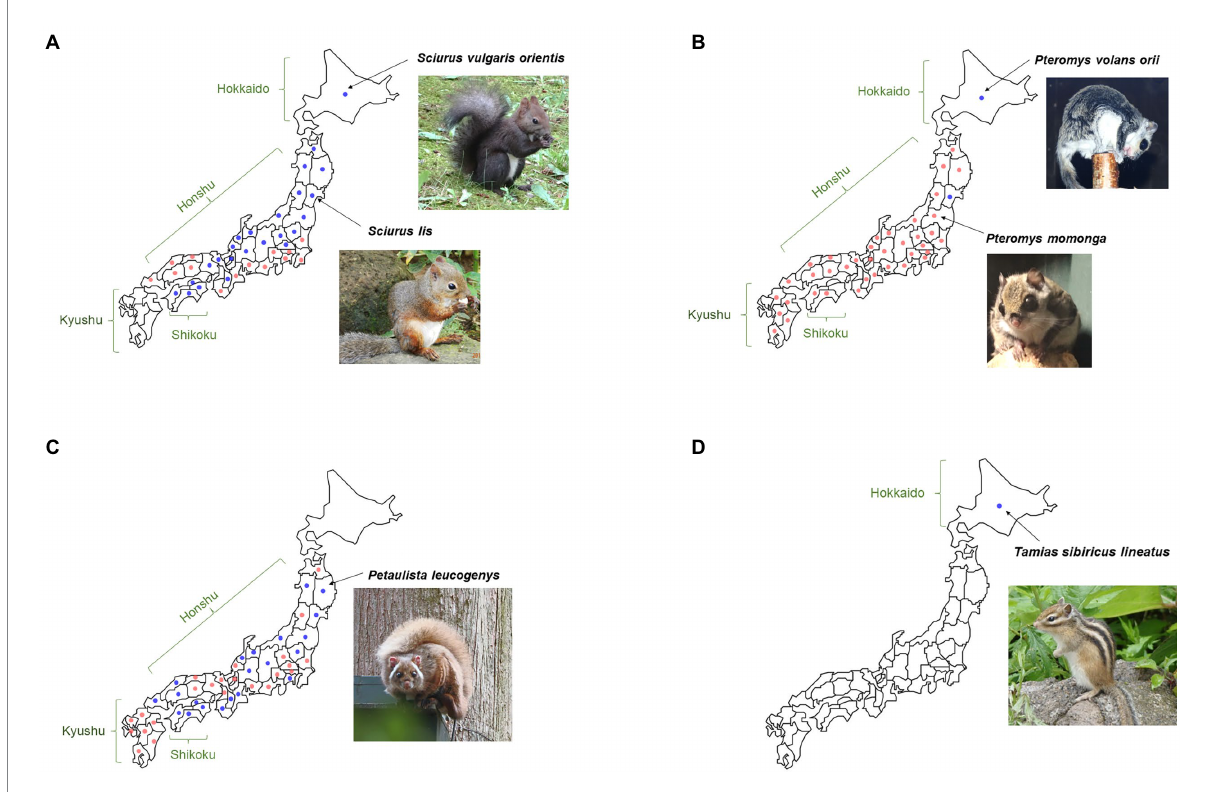
FIGURE 1 Distribution of the endemic species of squirrels in each prefecture. Blue circles indicate species that occur at normal densities in the prefecture, pink circles indicate those that are assessed as having low abundance and are listed on the Red List (Red List Data Search System, 2022). There are common criteria for the preparation of the Red List of mammals in each prefecture (Ministry of the Environment, Government of Japan, 2022). Information on the present status on each assessed species is collected from existing literature, documents, expert knowledge, and the results of field surveys. (A) Two species of arboreal tree squirrels, Sciurus lis and S. vulgaris orientis , (B) two species of flying squirrels, Pteromys momonga and P. volans , (C) the giant flying squirrel Petaurista leucogenys , and (D) the chipmunk, Tamias sibiricus lineatus